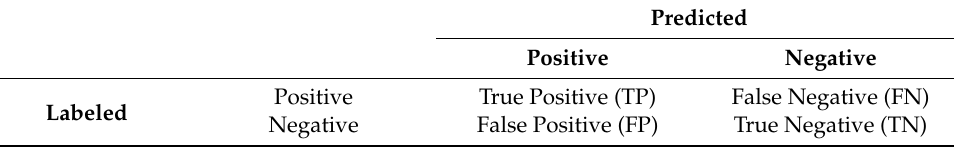
Table 5. Confusion matrix.